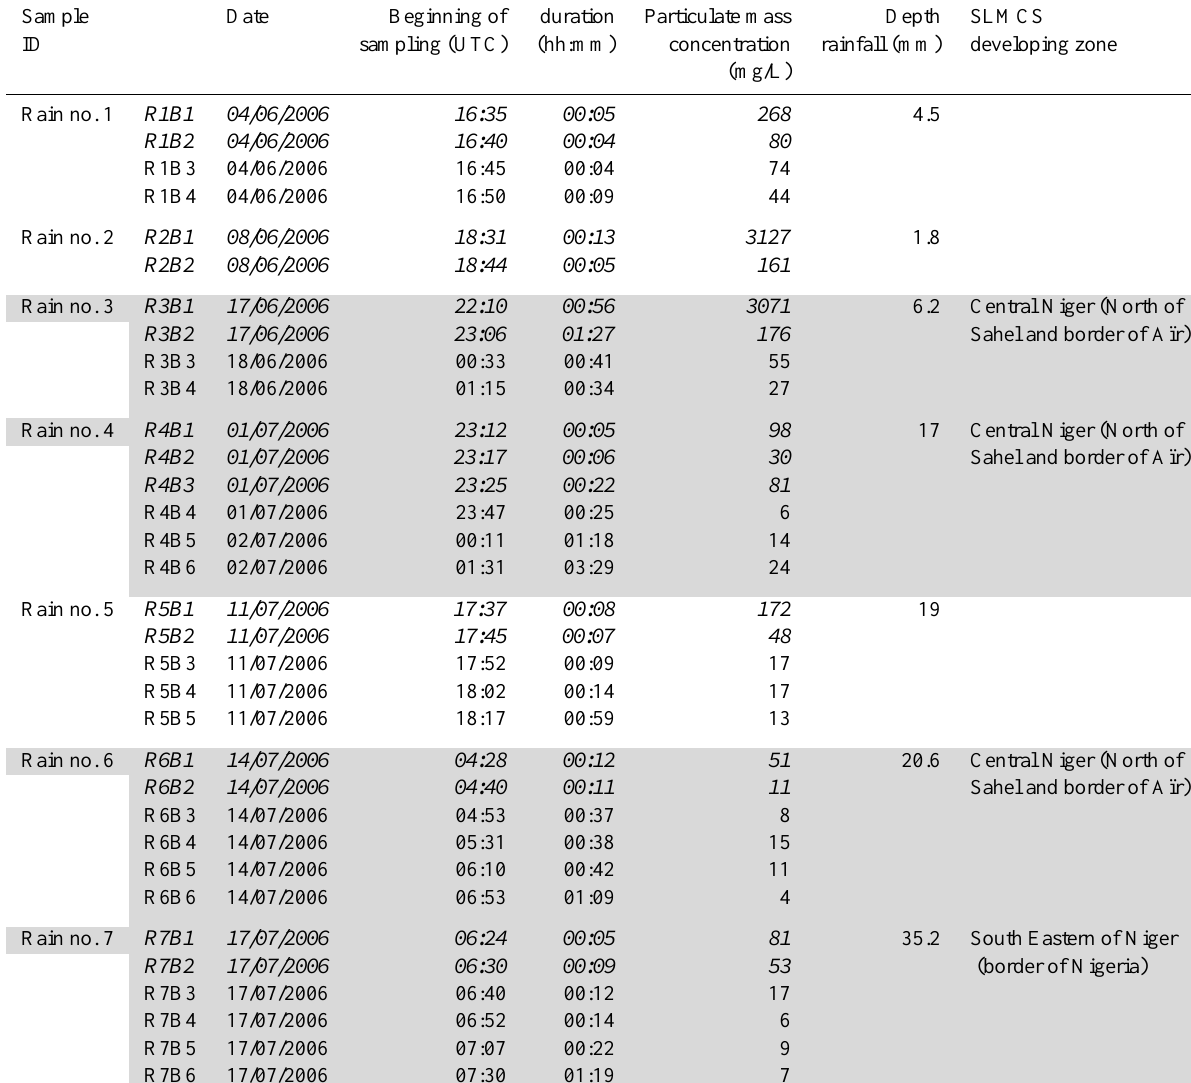
Table 1. Sample Identification and Main Operational Details for the rainwater sampled during AMMA SOP 1 and 2. Grey lines correspond to rain events collected from SLMCS. Samples presented in italic correspond with the samples which the elemental total composition is directly affected by local